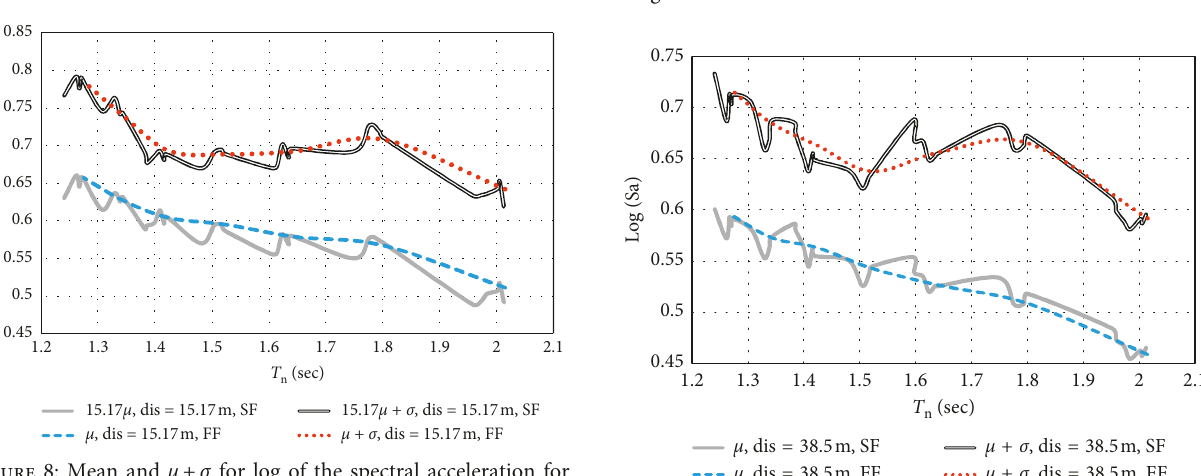
Figure 9: Mean and μ + σ for log of the spectral acceleration for models in the presence (SF) and absence (FF) of a tunnel at a distance of 26.83m from the center of the tunnel projection onto the ground surface.